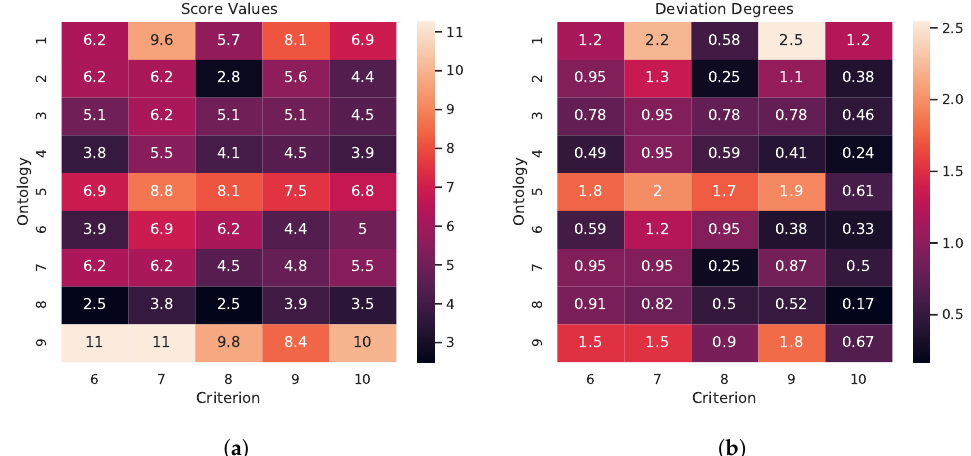
Figure 1. Score and deviation degree values for all alternatives in light of criteria 6 to 10. ( a ) Score values. ( b ) Deviation degree values.